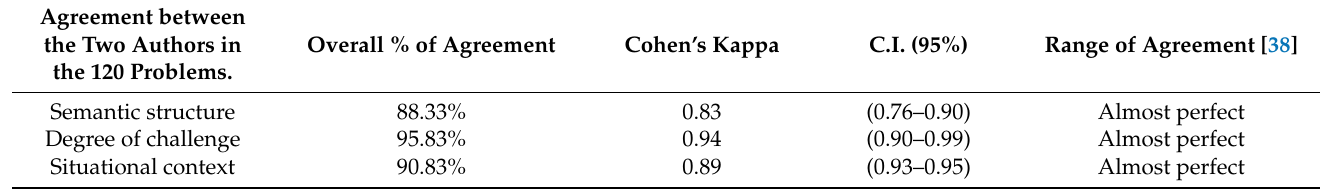
Table 1. Value and interpretation of Cohen’s Kappa index for the agreement between two judges. Authors of the study. Agreement between the Two Authors in the 120